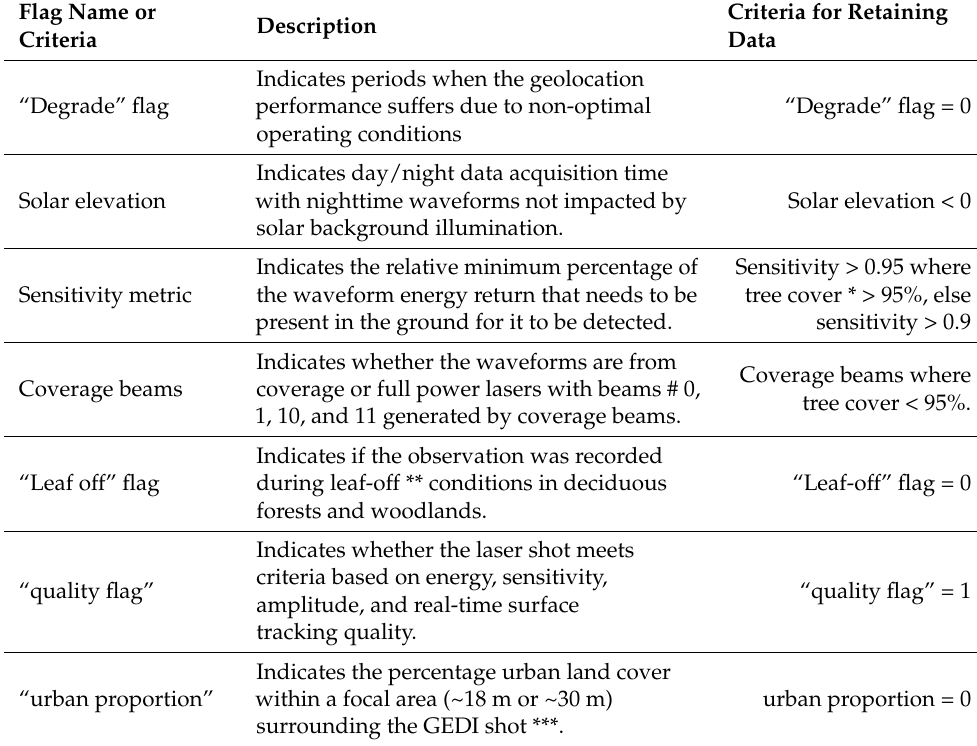
Table 2. Summary of the quality flags and the criteria used in this study for selecting the “best” GEDI